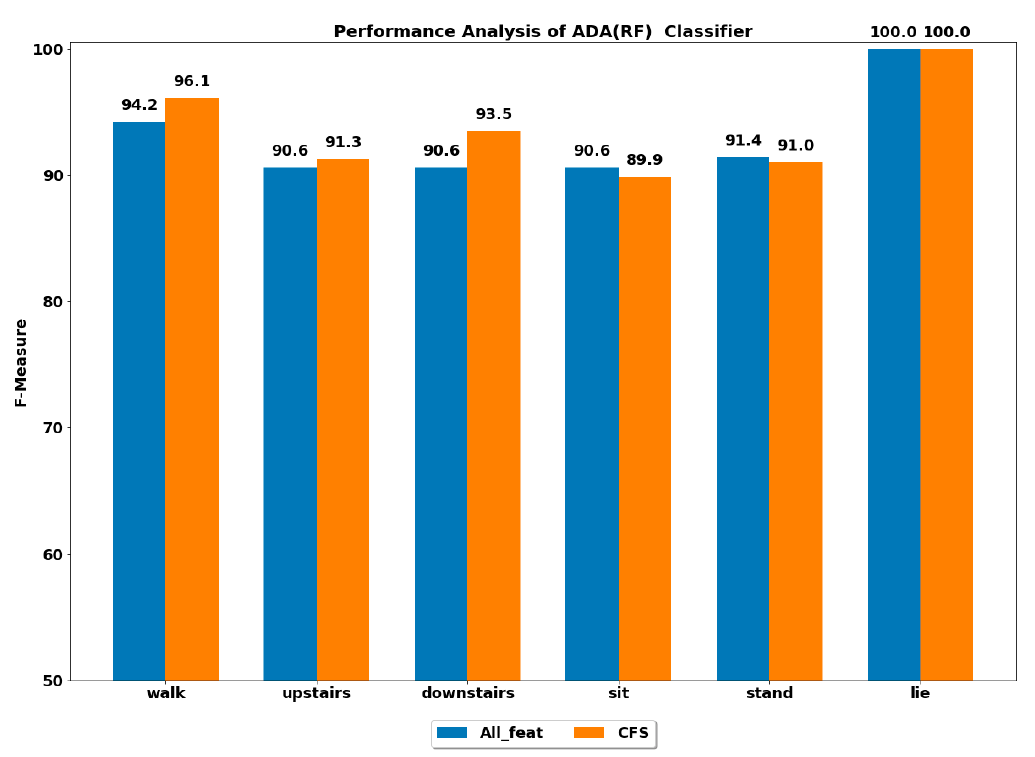
Figure 7. Performance analysis of ADA (DT) classifier with and without feature selection to classify set of ADLs.